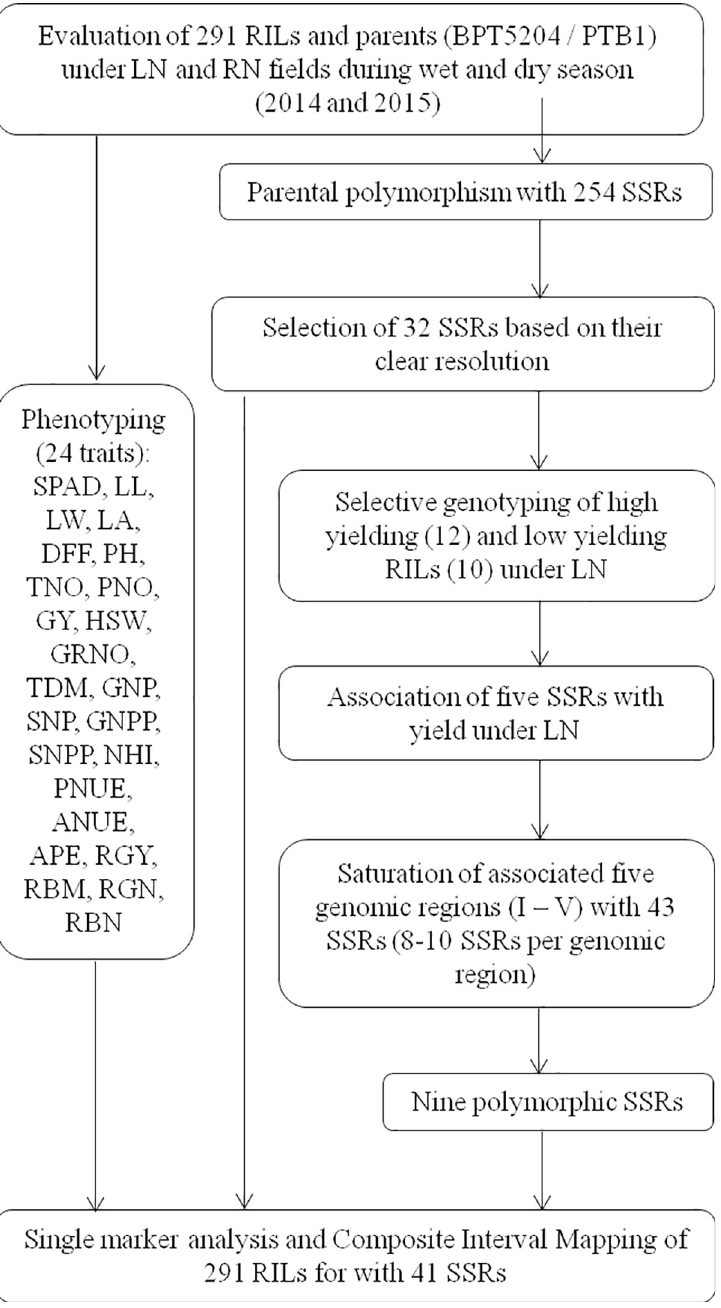
Fig 1. Schematic outline of phenotyping, parental polymorphism survey, selective genotyping, local linkage map construction and mapping. SPAD: SPAD value, LL: leaf length (cm), LW: leaf width (cm), LA: leaf area (cm), DFF: days to 50% flowering, PH: plant height (cm), TNO: tiller number, PNO: panicle number: GRNO: grain number, HSW: hundred seed weight (g), GY: grain yield per plant (g/plant), TDM: total dry matter (g/plant), GNP: grain nitrogen percent, SNP: straw nitrogen percent, GNPP: grain nitrogen/ plant, SNPP: straw nitrogen/ plant, NHI: nitrogen harvest index, RGY: relative grain yield, RBM: relative biomass yield, RGN: relative grain nitrogen, RBN: relative biomass nitrogen, PNUE: physiological nitrogen use efficiency, ANUE: agronomic nitrogen use efficiency, APE: agro- physiological efficiency.